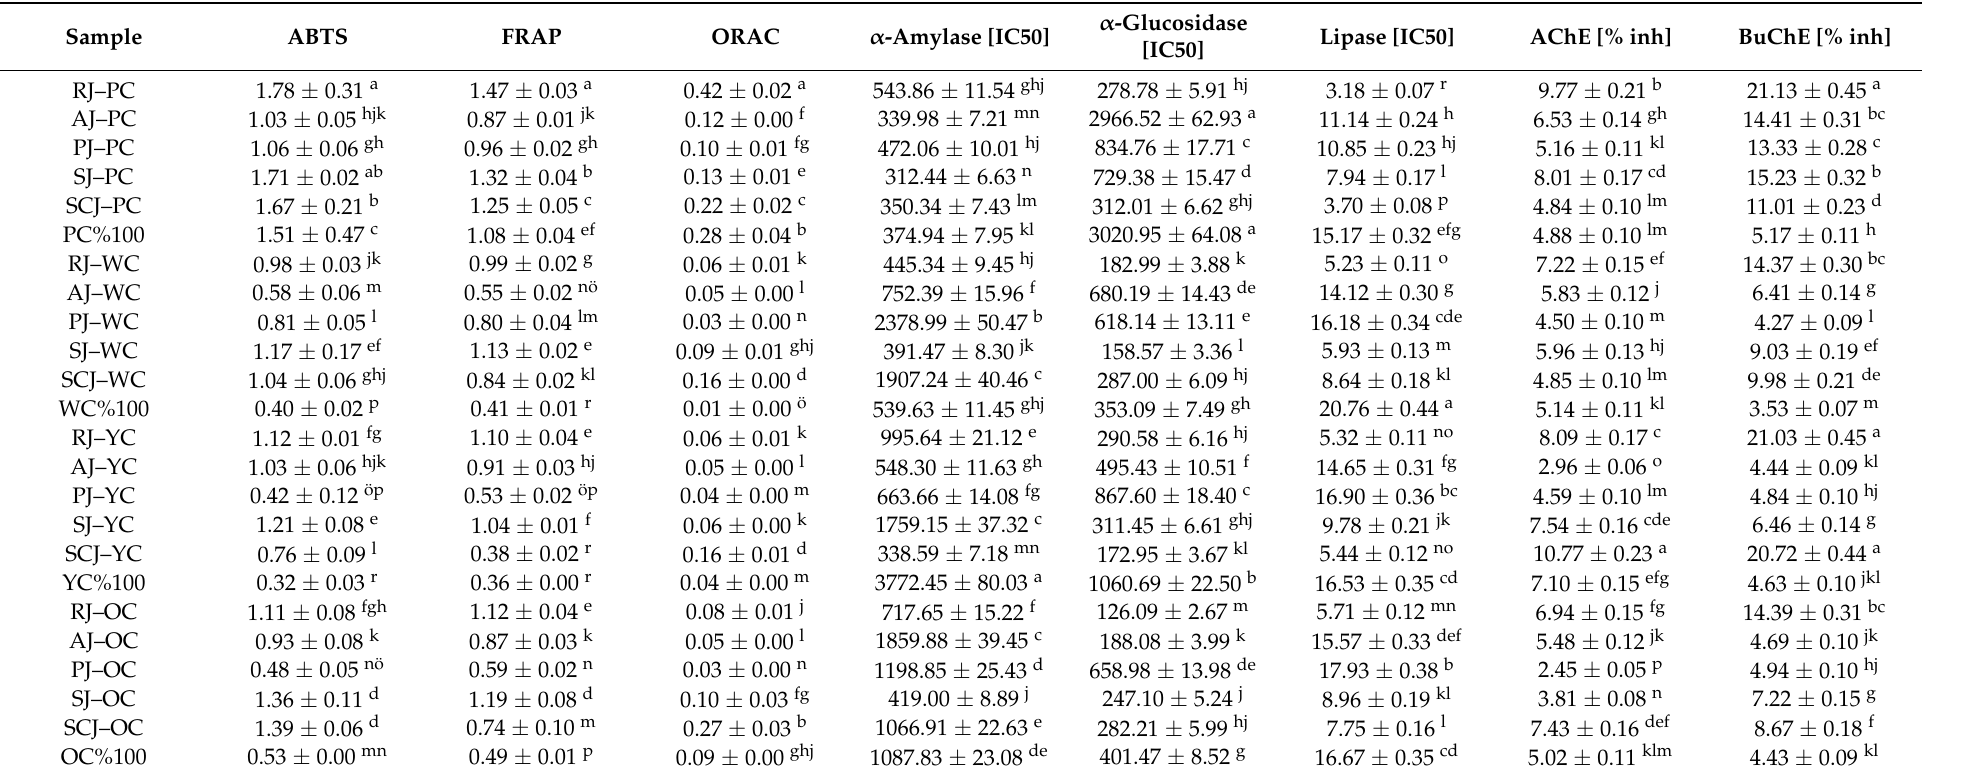
Table 4. The antioxidant [mmol TE/100 mL] and in vitro inhibition activities (acetylcholinesterase, butyrylcholinesterase, α -amylase, α -glucosidase, pancreatic lipase) of carrot-based